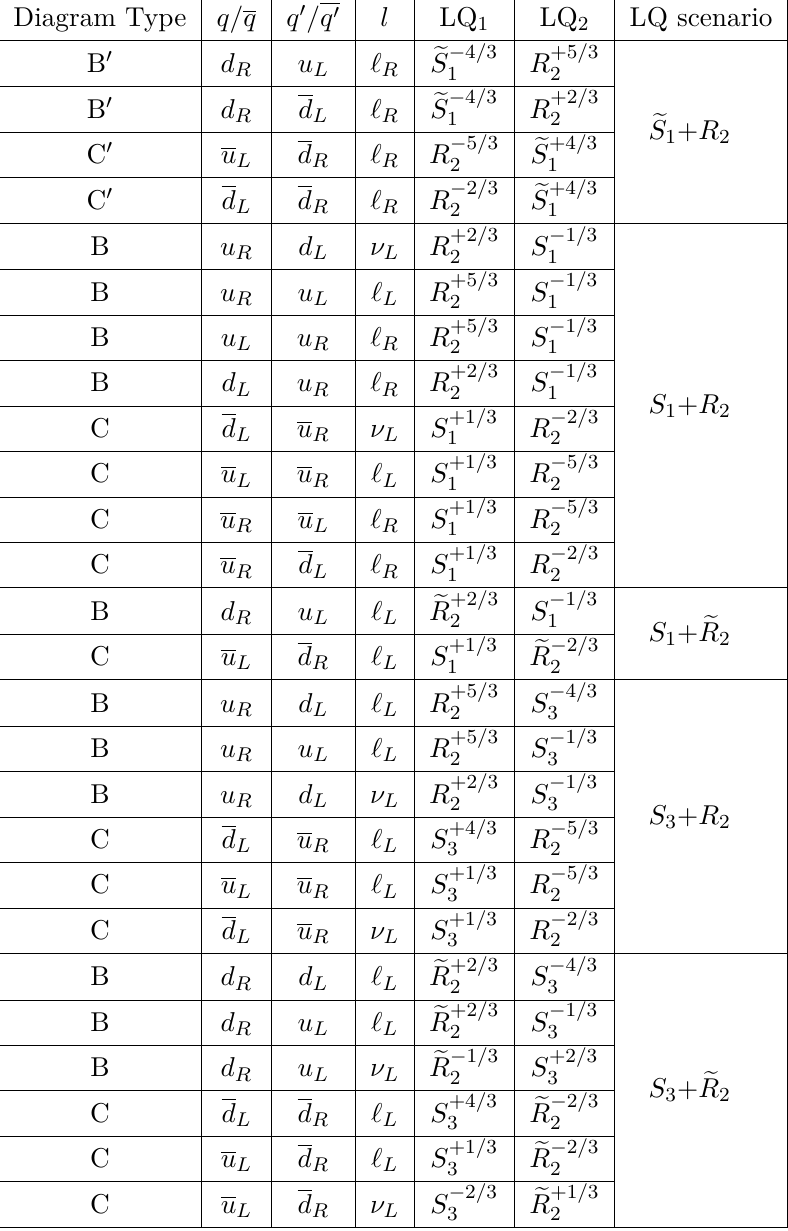
production cross sections. We work, for simplicity, at the leading order in QCD and denote the cross sections of interest